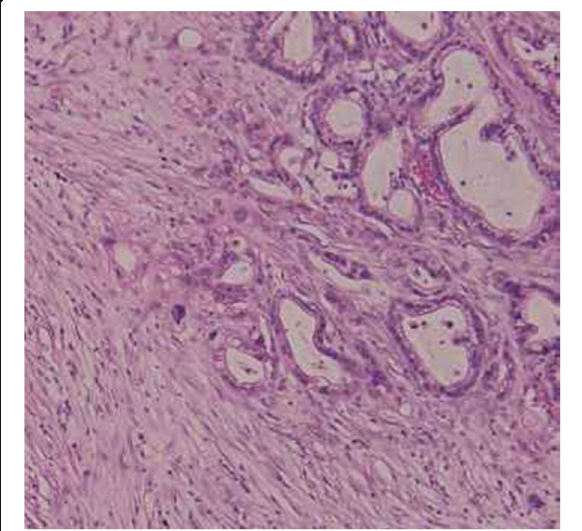
Fig. 1 Histopathological findings of resected specimen of the pancreas. Moderately to poorly differentiated ductal adenocarcinoma was seen in the